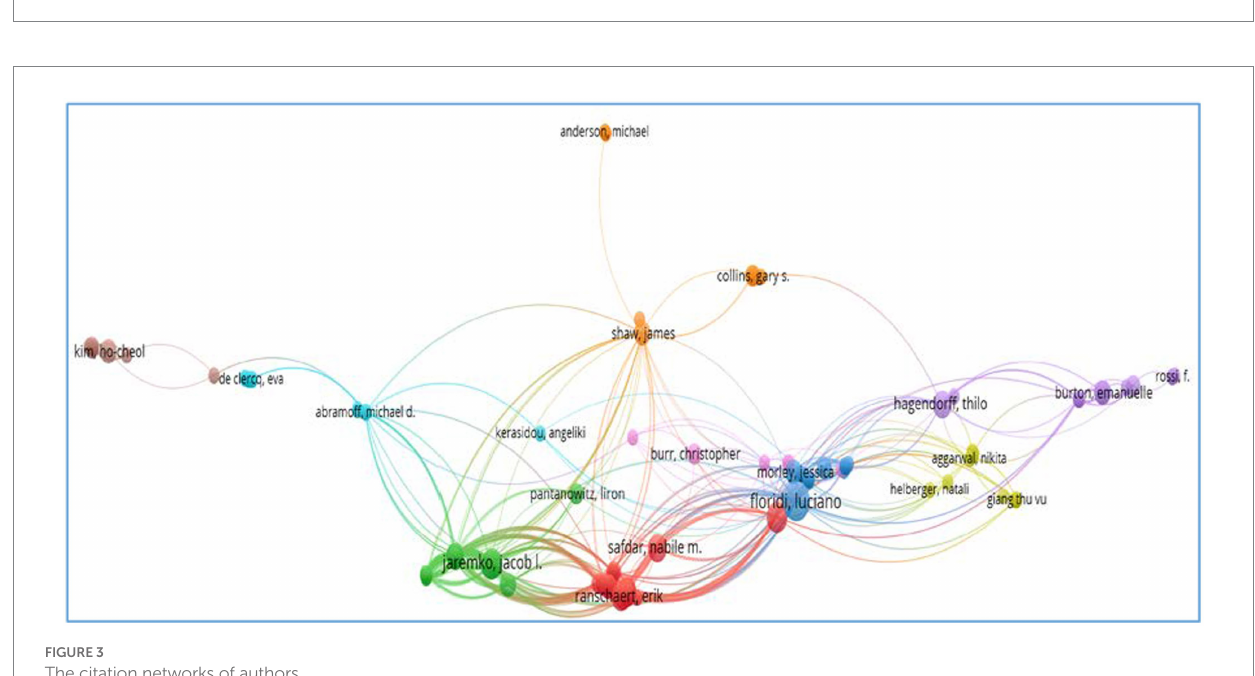
FIGURE 2 The trend of publications regarding ethics of AI for educational purposes.